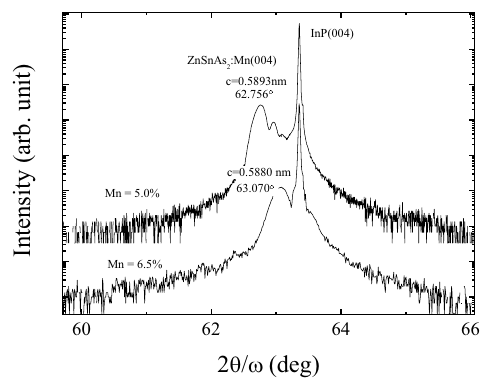
Figure 1. High-resolution XRD profiles of Mn-doped ZnSnAs 2 thin films with Mn concentations of 5.0 % and 6.5% on InP (001) substrates.